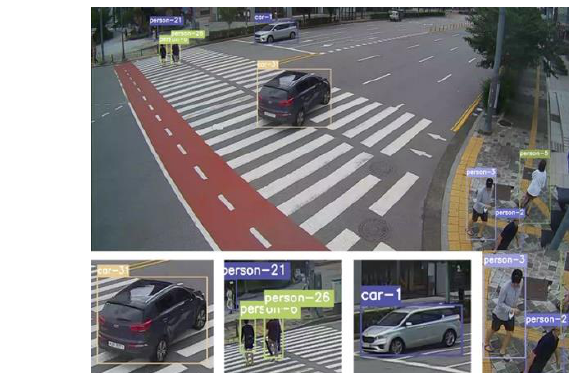
Figure 7. Process for error estimation in the global coordinate system.